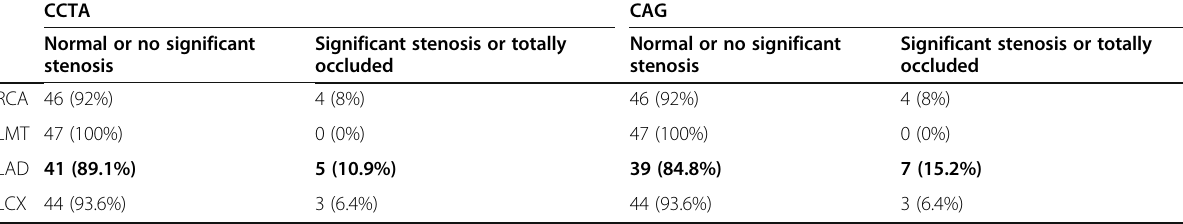
Significant stenosis or totally occluded